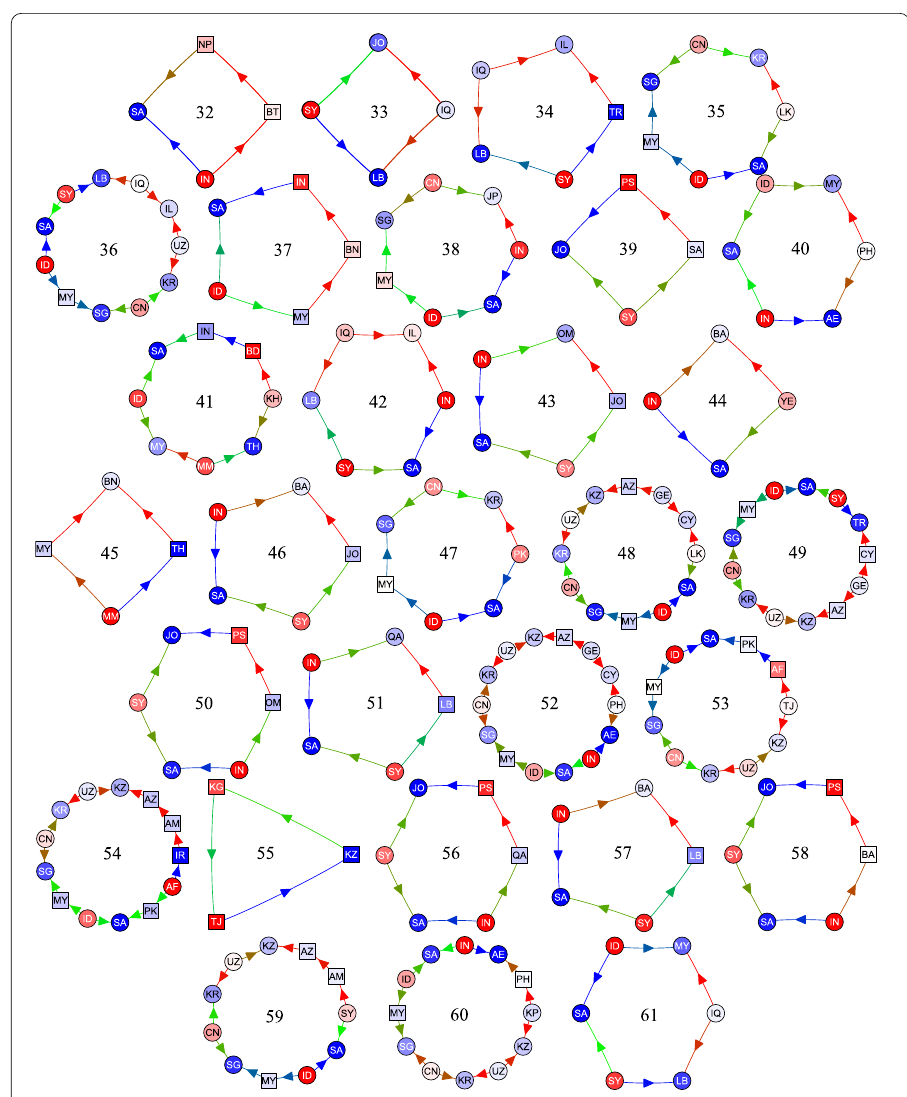
Figure 11 Cyclic patterns of Asian migration continued. 1-cycle generators for the 2015 Asian net migration network. See Fig. 10 for details